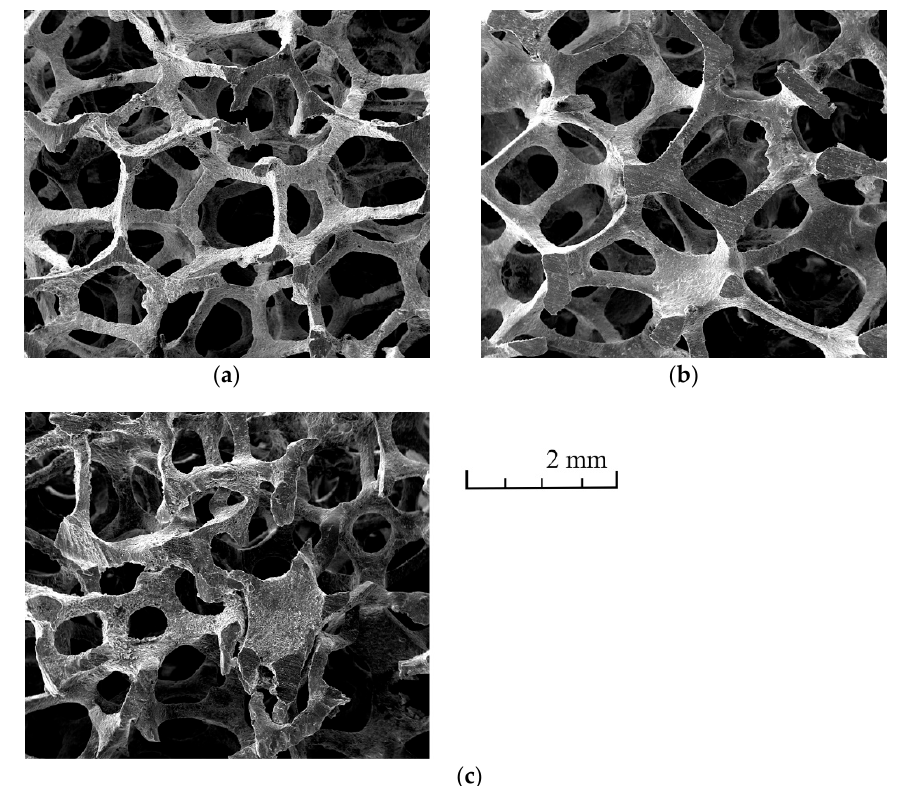
Figure 7. Measured pressure drop comparison for air, water and oil flowing through 30 PPI foam.